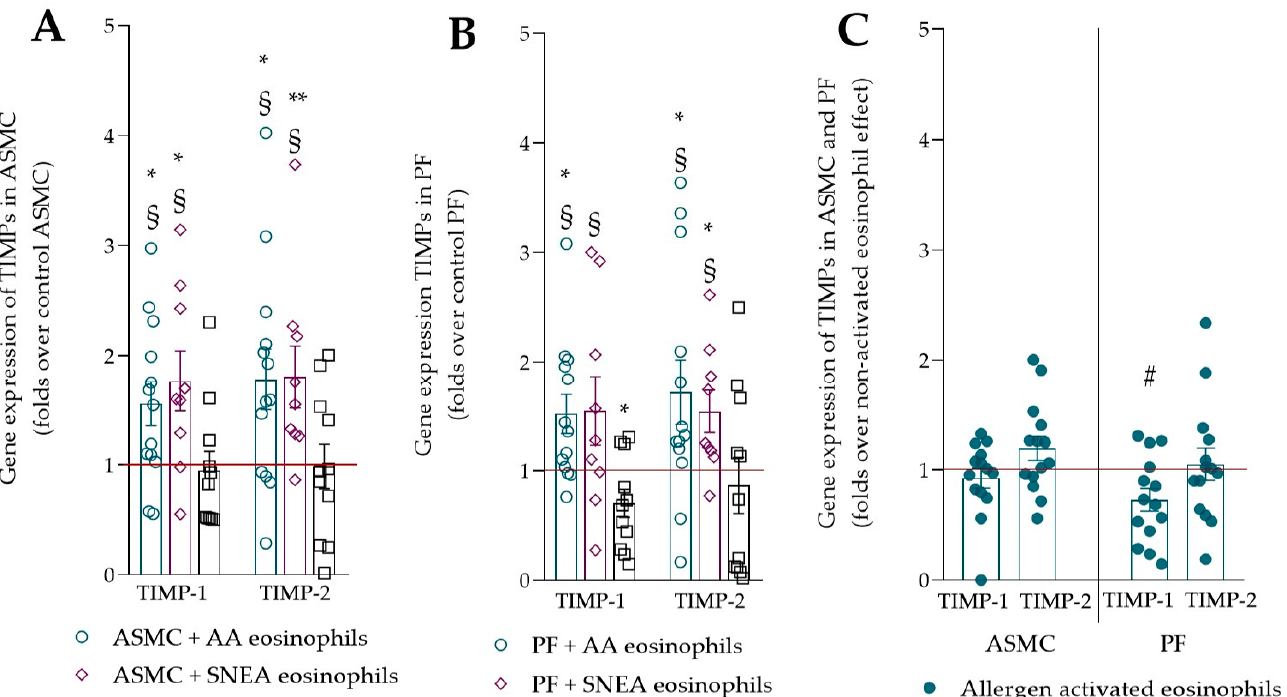
Figure 3. ( A )—Gene expression of TIMPs in ASMC; ( B )—gene expression of TIMPs in PF; ( C )—gene expression of TIMPs in ASMC and PF after incubation with allergen-activated